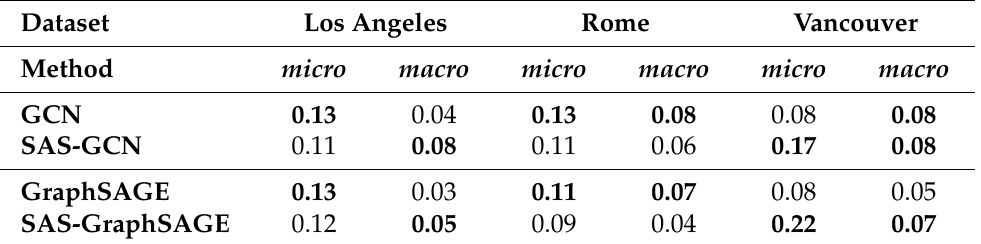
Table 5. Summary of results for the Graph Convolutional Networks (GCN) and GraphSAGE. We compare results with models trained using our sampling technique SAS-GCN and SAS-GraphSAGE. The metric used here is the micro and macro-averaged F1-score. Results presented are the